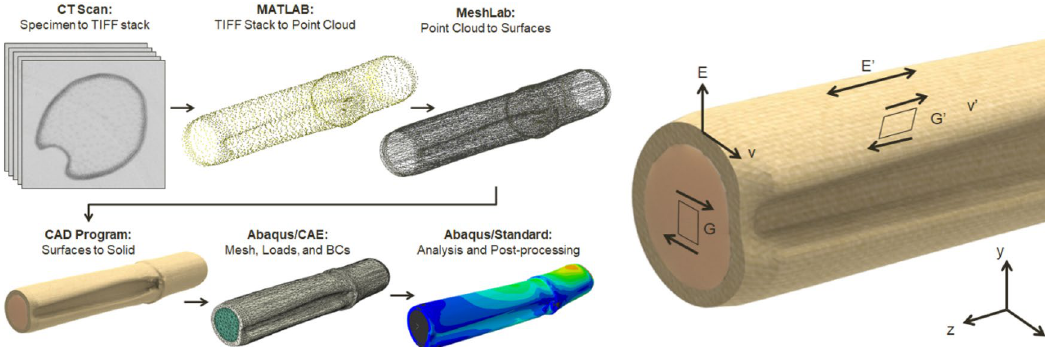
Figure 3. The process used in creating computational models of a maize stem. Left: CT scans were processed to create finite element models using the steps shown. Right: depiction of the rind and pith tissue regions as well as the transversely isotropic mechanical